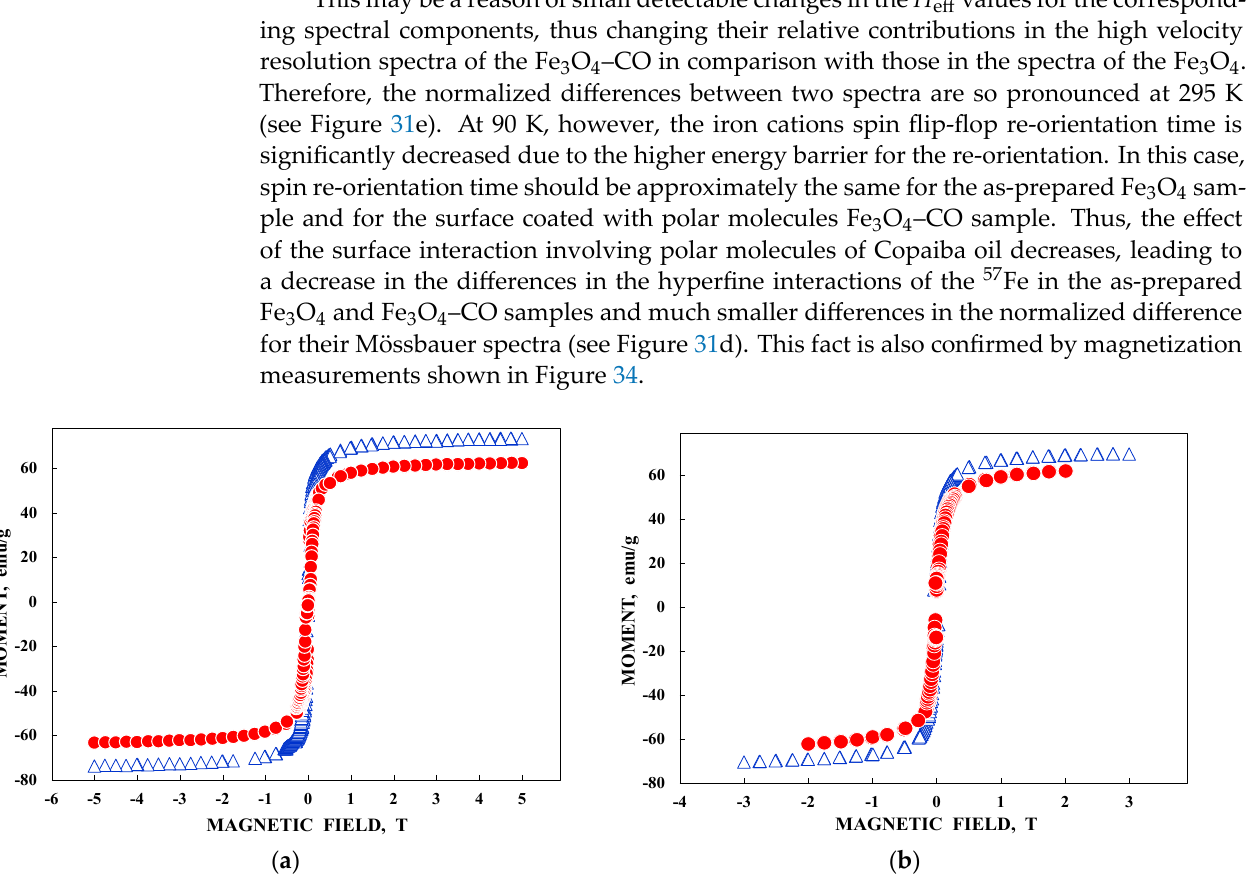
Figure 34. A decrease in the differences in magnetization for the as‑prepared Fe 3 O 4 ( • ) and dispersed in Copaiba oil Fe 3 O 4 ‑CO ( △ ) samples with temperature decrease from 294 K ( a ) down to 8 K ( b ). Adapted from Ref. [71] with permission from Springer Nature: Hyperfine Interactions, “Mag ‐ netite nanoparticles as ‐ prepared and dispersed in Copaiba oil: study using magnetic measure ‐ ments and Mössbauer spectroscopy”, Oshtrakh M.I., Ushakov M.V., Semenova A.S., Kellerman